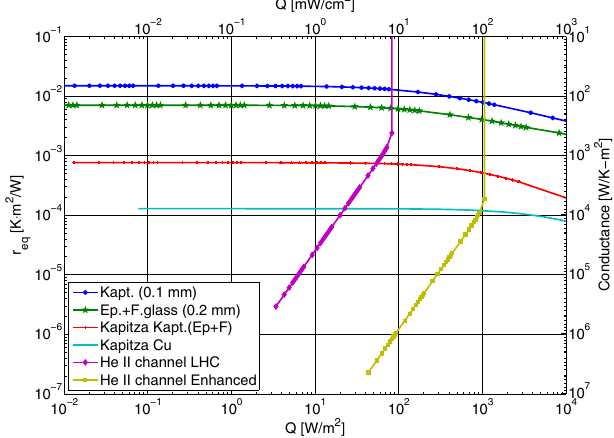
FIG. 5. (Color) Equivalent thermal resistances of insulation components in a 1.9 K helium bath.